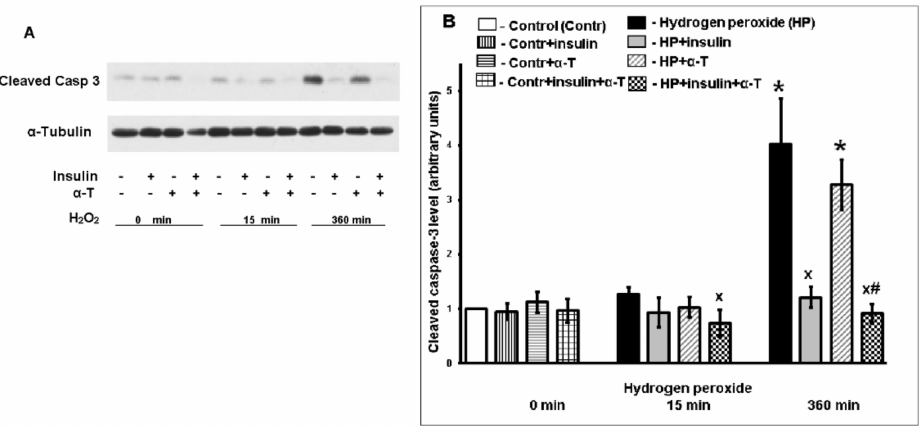
Figure 2. The antiapoptotic effect of insulin plus α -T on rat brain cortical neurons exposed to hydrogen peroxide is more pronounced than the effect of each drug. ( A ) immunoblots of cleaved caspase-3 are shown. ( B ) the data of 10 experiments are presented as the means ± SEM. Abbreviations used: Casp3–caspase-3. Cortical neurons were pre-incubated for 1 h with 1 µ M insulin or for 18 h with 50 µ M α -T or with both drugs or without them. Then the neurons were exposed to 100 µ M hydrogen peroxide for 0, 15 min and 6 h. The differences are significant according to Student’s paired t -test as compared: *—to control, x—to the effect of hydrogen peroxide alone, #—to the effect of either insulin or α -T alone, p < 0.01 in all